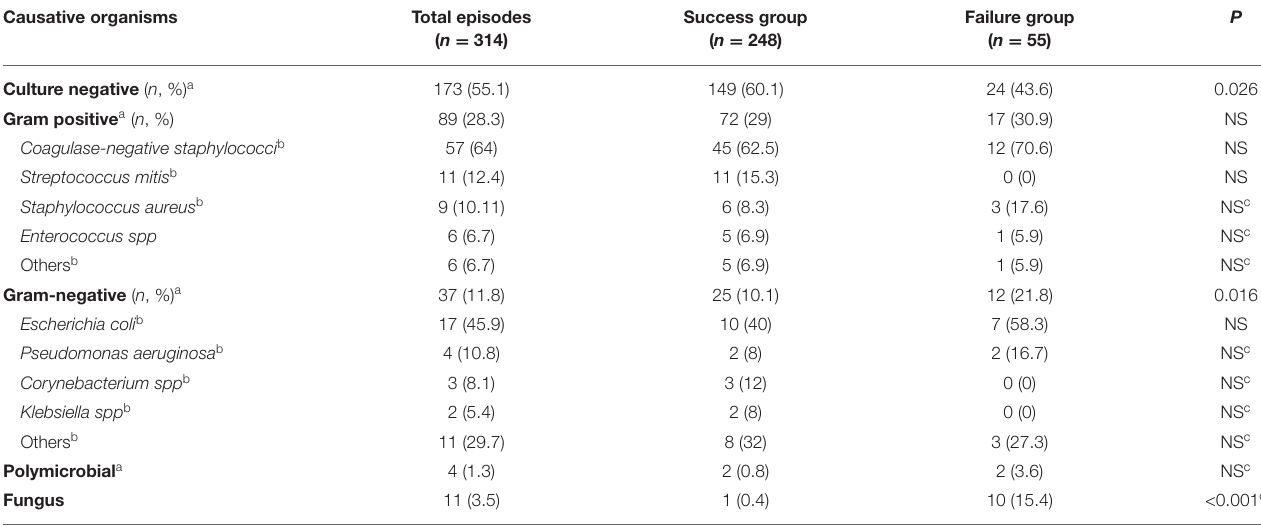
TABLE 2 | Causative organisms of the 314 peritonitis episodes. Causative organisms